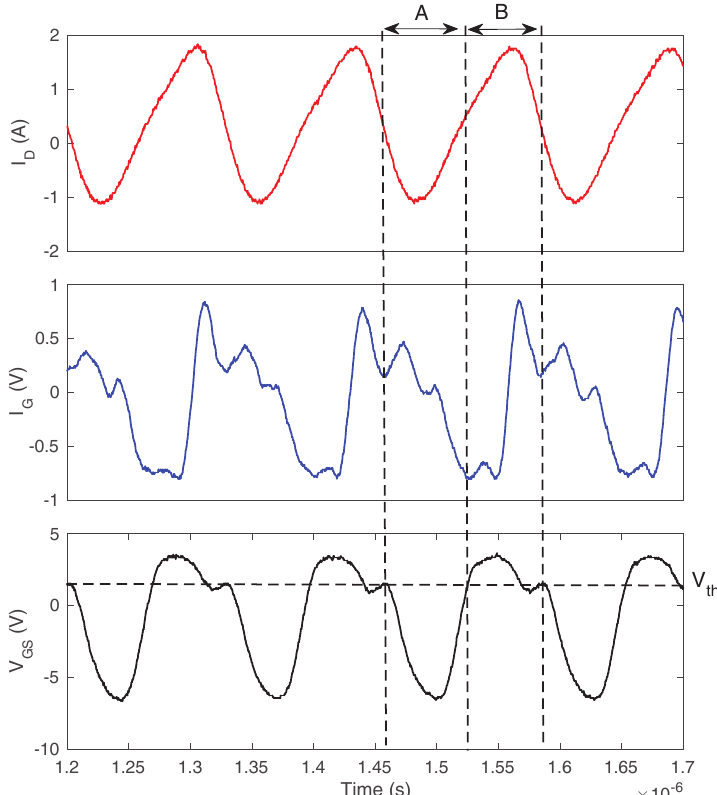
Figure 6. The type II oscillation waveforms of I D , V GS , and I G (Polarities defined in Figure 2).